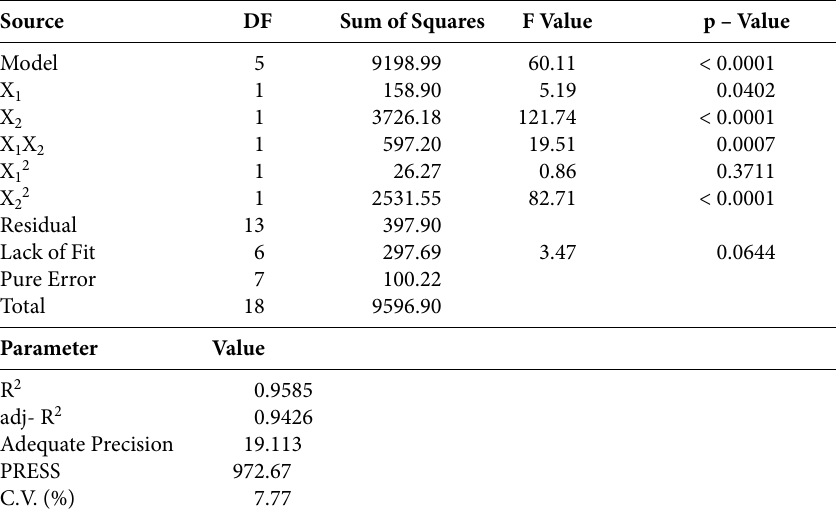
Table 3. ANOVA table representing the effect of linear, quadratic and interaction terms on extraction yield for UAE model and statistical parameters Source DF Sum of